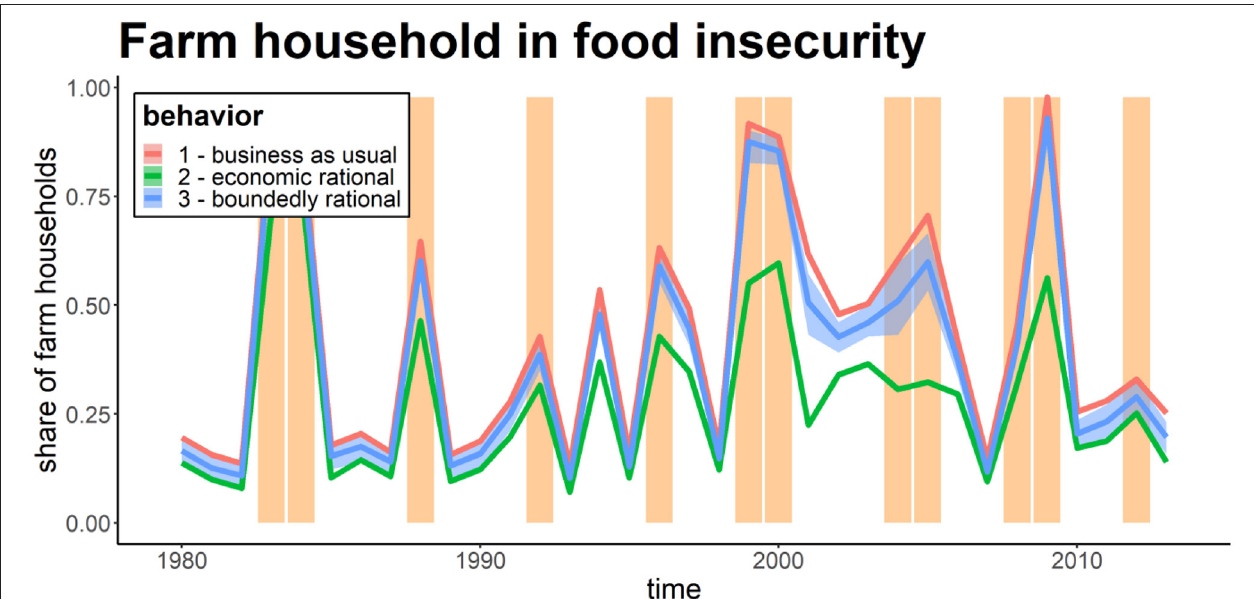
FIGURE 6 | Share of households in food insecurity over time. Variability over time visualized for three behavioral scenarios: economic rational (EUT), bounded rational (PMT), and no adaptation decisions (BAU). Drought years (SPEI value in crop season < − 1) are visualized as vertical orange bars. The shaded blue area shows the variance among 50 bounded rational model runs, a result of the variety in weights of the PMT factors.